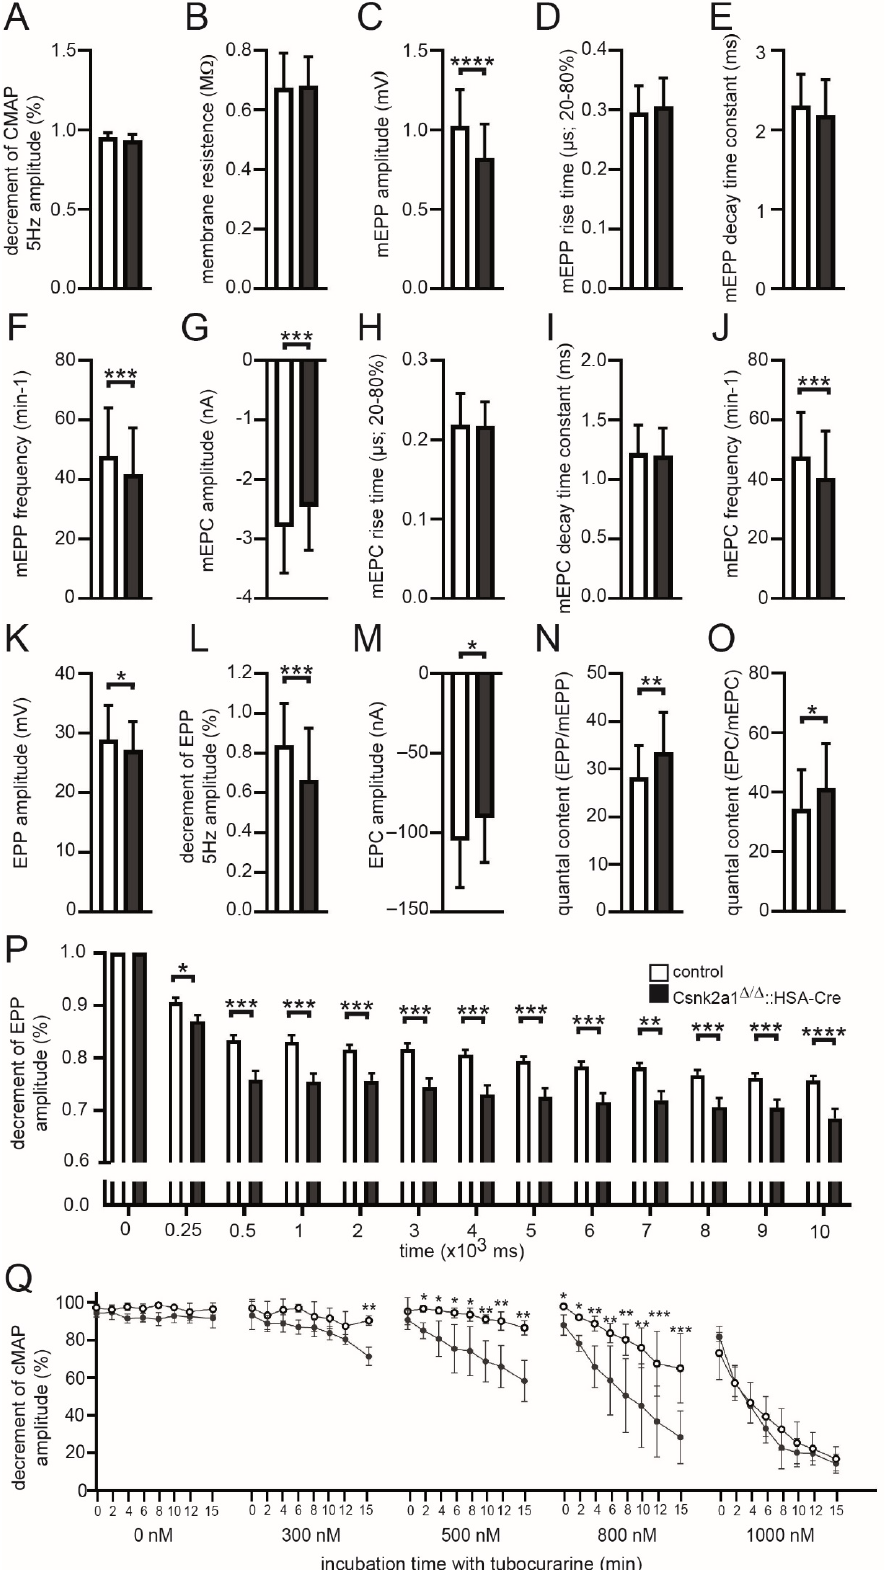
Figure 5. Characterization of neural transmission recording of conditional Csnk2a1 knockout mice. Diaphragms of adult mice of indicated genotypes were employed for electrophysiological